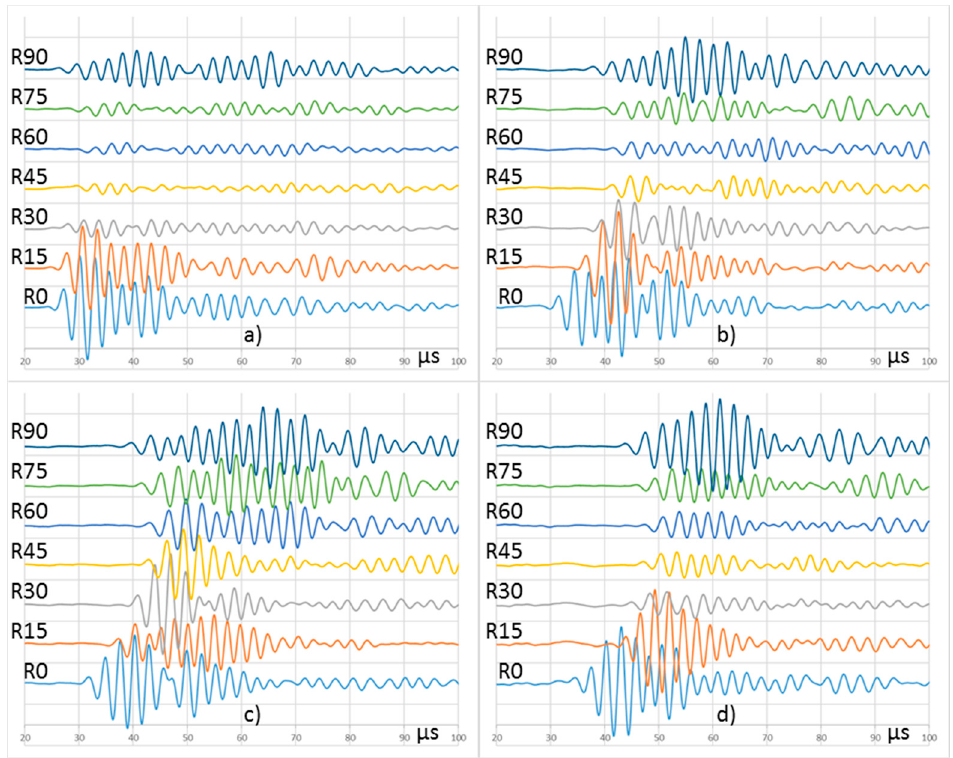
Figure 15. Signals acquired in R0 to R90 following procedure P2 when different delays are applied to the emitting PWAS E1 to E10: ( a ) 0.33 µs, ( b ) 1.60 µs, ( c ) 1.80 µs, and ( d ) 2.33 µs. An offset was added to each signal for easy display. Vertical scale is 100 mV/div. Table 3. Peak-to-peak voltage measured (in mV) at R0 to R90 in the UGWT run following procedure P1 and procedure P2 with 10 PWAS and different delays in emission.